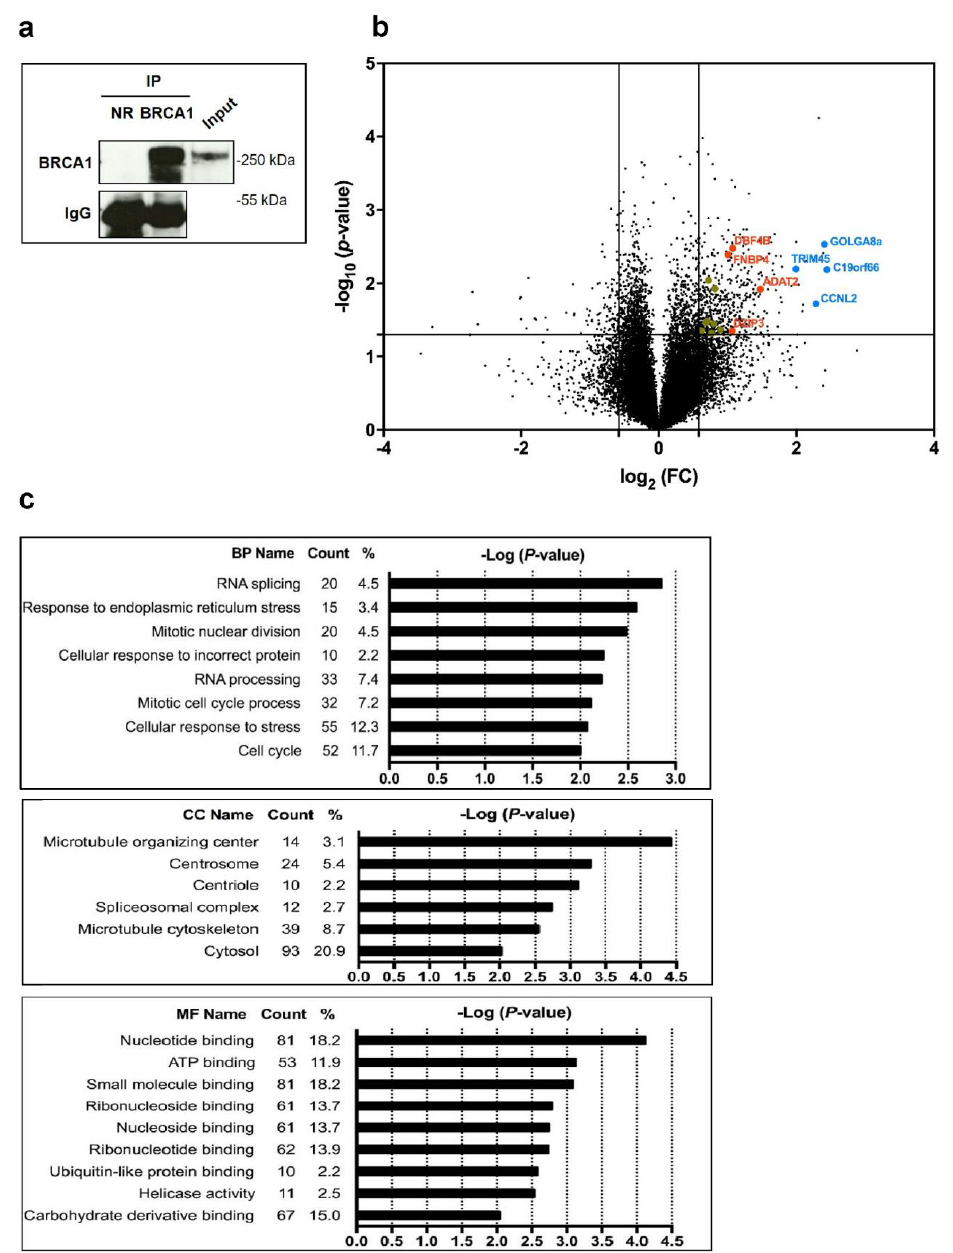
Figure 1. Identification of BRCA1-associated mRNAs using large-scale analysis. RNA-binding protein immunoprecipitation (RIP) performed in triplicate followed by microarray analysis. ( a ) Immunoblots showing that BRCA1 is immunoprecipitated in MCF-7 cells. Immunoprecipitation with anti-BRCA1 antibody (BRCA1) and with a control IgG (NR). ( b ) Microarray analysis of the BRCA1-associated mRNA isolated by RIP. Lines indicate –log10 ( p -value) ≥ 1.3 and abs (log2 (Fc)) ≥ 0.6 for p ≤ 0.05 and abs (Fc) ≥ 1.5 respectively. Among the mRNAs displaying a fold change (Fc) above 1.5, the 16 mRNA of interest (listed in Figure 2a) were colored in gray (1.5 ≤ Fc < 2.0), orange (2.0 ≤ Fc < 3.0), and blue (3.0 ≤ Fc ≤ 5.4). The name of the 8 genes with the most changes (colored in blue and orange) was included. ( c ) Gene ontology analysis of mRNA bound to BRCA1, using DAVID (Database for Annotation, Visualization and Integrated Discovery). BP: biological process; CC: cellular compartment; MF: molecular